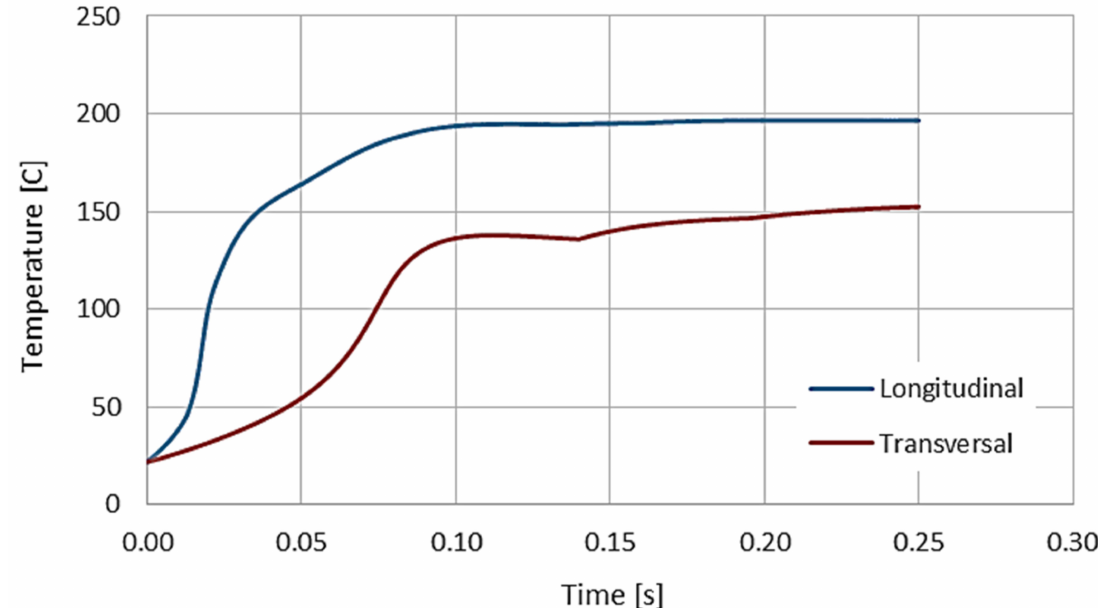
Figure 13. Comparison of the time needed for reaching and the values of the maximum temperatures for the longitudinal and transverse type of